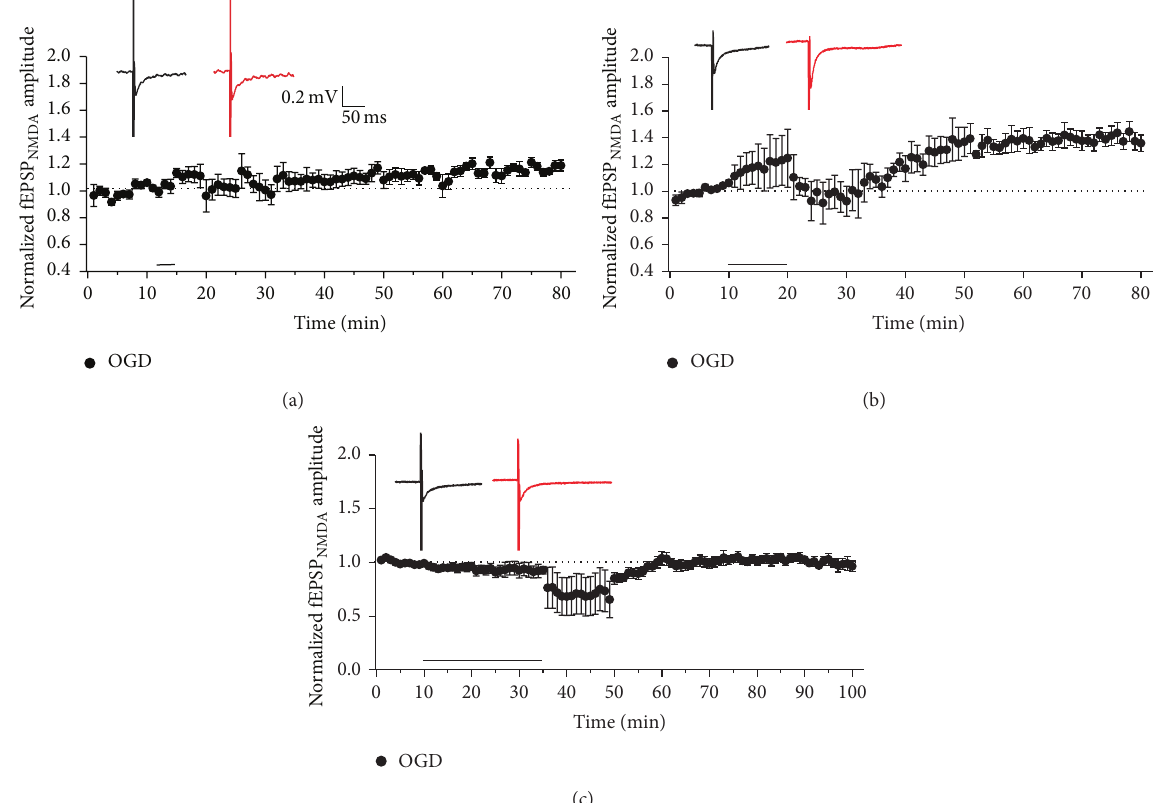
Figure 1: NMDAR-mediated plasticity recorded by fEPSPs is induced using OGD treatment with different time periods. Exposure to 3 min (a), 10min (b), and 25 min (c) of OGD showed a slight but persistent increase of fEPSP amplitude ( 1.18 ± 0.03 , compared with baseline, 𝑛 = 6 , 𝑃 < 0.05 ), significant potentiation of fEPSP amplitude ( 1.37 ± 0.07 , compared with baseline, 𝑛 = 5 , 𝑃 < 0.05 ), and no obvious effects ( 1.03 ± 0.04 , 𝑛 = 5 , 𝑃 > 0.05 ) on fEPSP amplitude, respectively. Inset: sample traces were from average of the first 10 sweeps in baseline and average of the last 10 sweeps of the whole